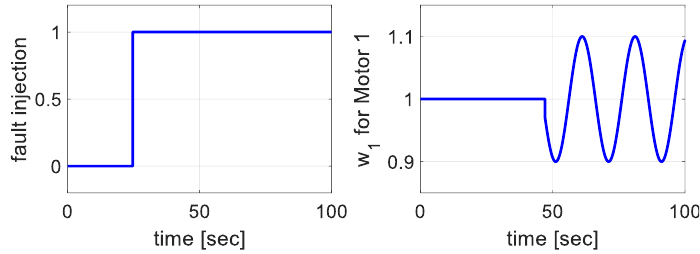
Figure 18. Signals for the fault injection (left) and time-varying weight 𝑤 1 (right).